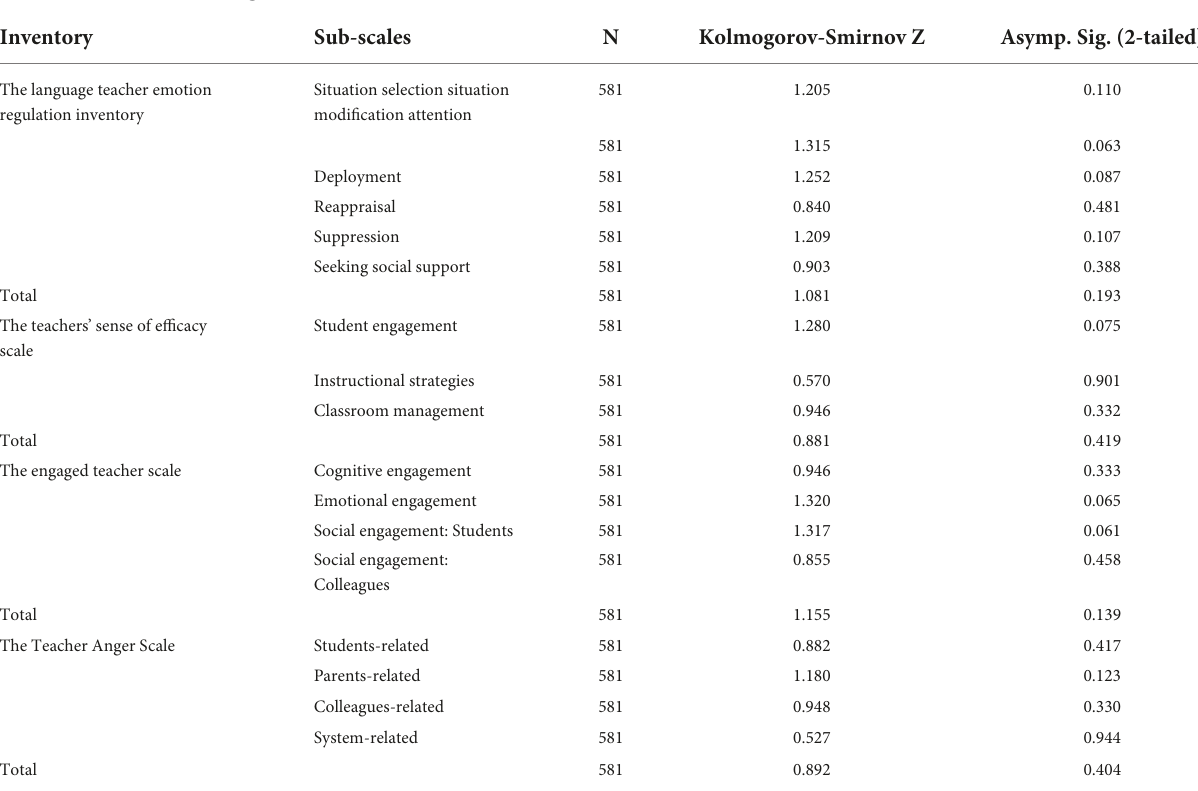
TABLE 2 The results of Kolmogorov-Smirnov